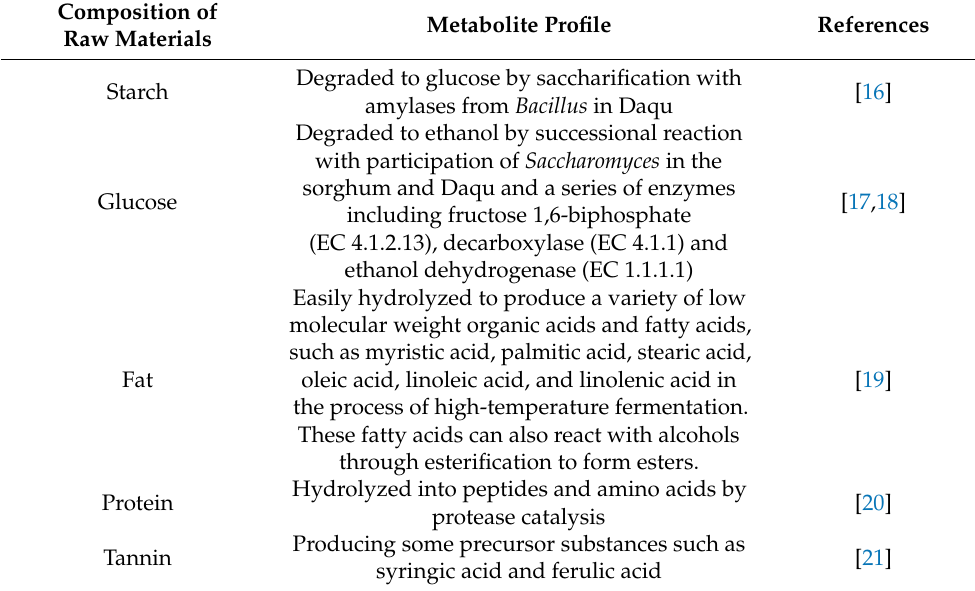
Table 1. Metabolic patterns of components in raw materials during